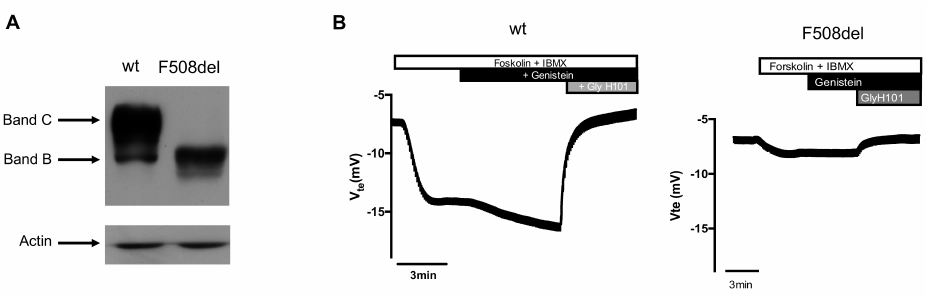
Figure 1. Biochemical and functional analysis of cystic fibrosis bronchial epithelial (CFBE) cells expressing wt- or F508del-cystic fibrosis transmembrane conductance regulator (CFTR). ( A ) Western Blot was used to assess the expression of CFTR in stably transduced CFBE cells and ( B ) transepithelial transport was assessed by Ussing chamber measurements of polarized CFBE cells expressing each variant.